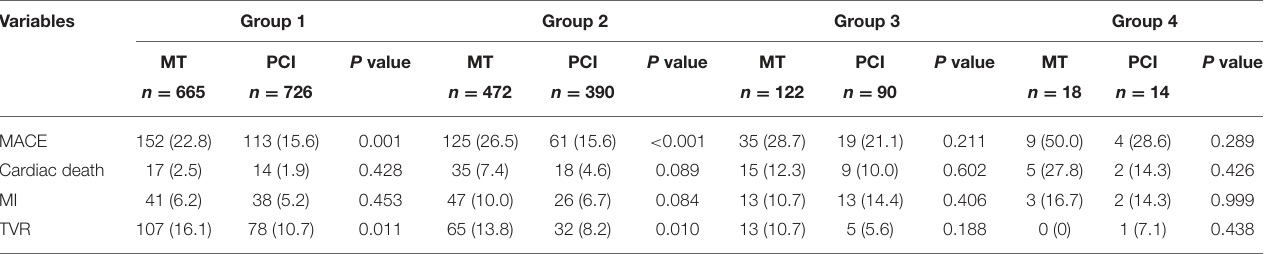
TABLE 4 | Clinical outcomes of all patients stratified by eGFR in the medical therapy and PCI groups.